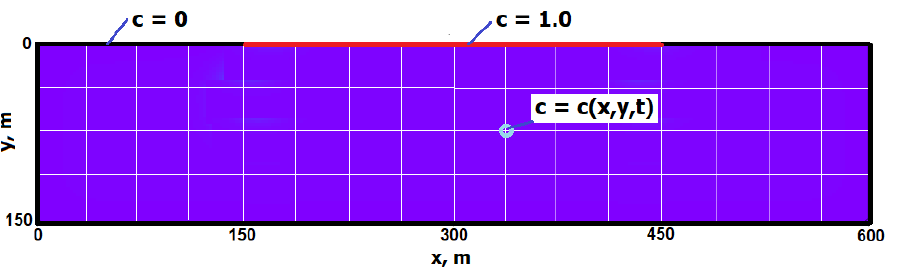
Figure 1. The Elder problem: domain, boundary conditions, and the l = 2 grid. Table 1. Parameters of the Elder